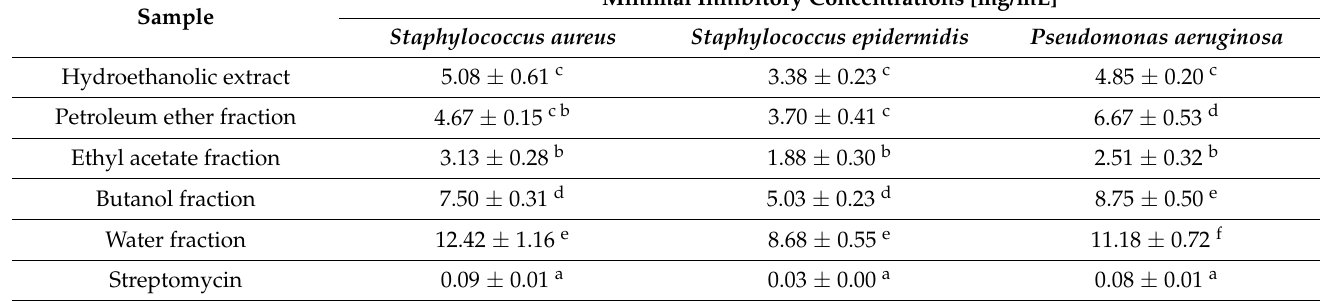
Table 5. Antibacterial activity of the hydroethanolic extract of the aerial parts of Sideritis raeseri subsp. raeseri and its